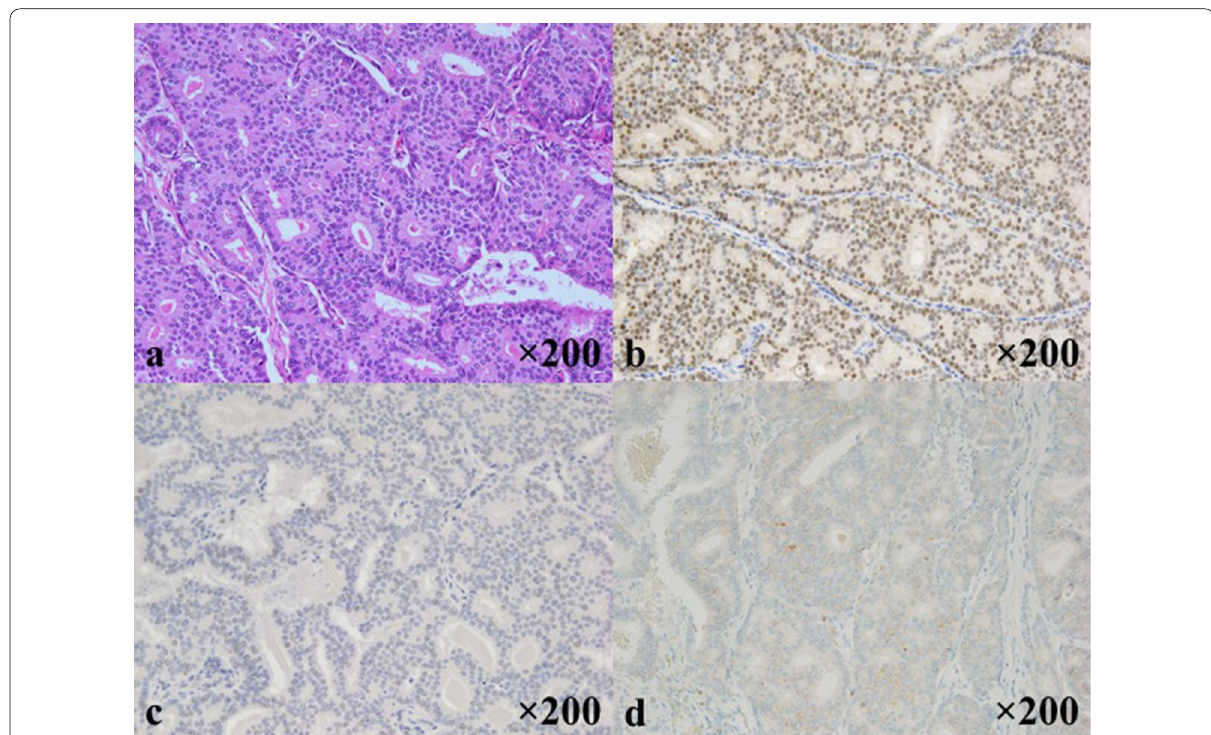
Fig. 3 Pathological findings of the metastatic lesion. Characteristics resemble the primary breast cancer of 11 years ago. Pathological diagnosis was metastatic ductal carcinoma. a H&E staining (